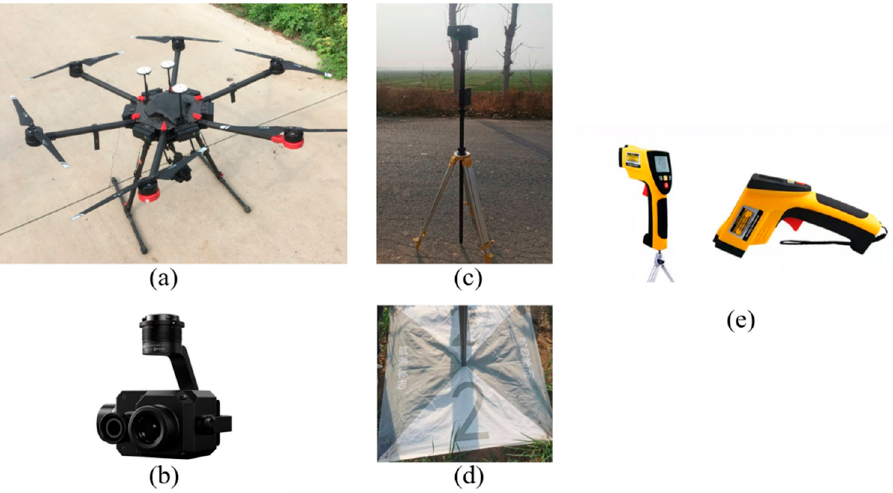
Figure 2. The main instruments for obtaining CT in this study include ( a ) Matrice M600 Pro UAV, ( b ) Zenmuse XT2 camera, ( c ) D-RTK2 mobile GNSS station, ( d ) Ground control point, and ( e ) Handheld infrared thermometer.